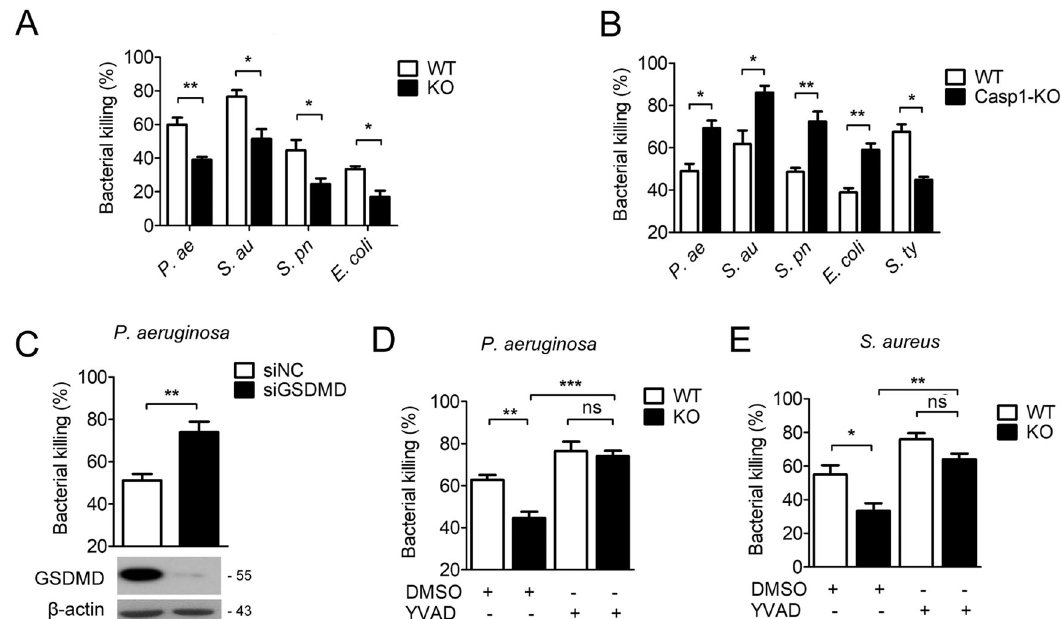
Fig. 2 Pyroptosis suppresses macrophage-mediated pyogenic bacteria eradication. A , B TREM2 KO (KO) or Caspase-1-KO vs. WT BMDMs were infected with Pseudomonas aeruginosa , Staphylococcus aureus , Streptococcus pneumoniae , Escherichia coli (MOI = 20). C BMDMs were transiently transfected with siGSDMD vs. siNC, followed by Pseudomonas aeruginosa infection (MOI = 20). D , E TREM2 KO vs. WT BMDMs were pretreated with Ac-YVAD-CMK (40 μ M) or DMSO, followed by Pseudomonas aeruginosa or Staphylococcus aureus infection (MOI = 20). The bacterial killing ef fi ciency was assessed by bacterial killing assay based on plate count. C Protein levels of GSDMD were detected by western blot. Data are shown as the mean ± SEM of three individual experiments. * P < 0.05; ** P < 0.01; *** P < 0.001. ns no signi fi